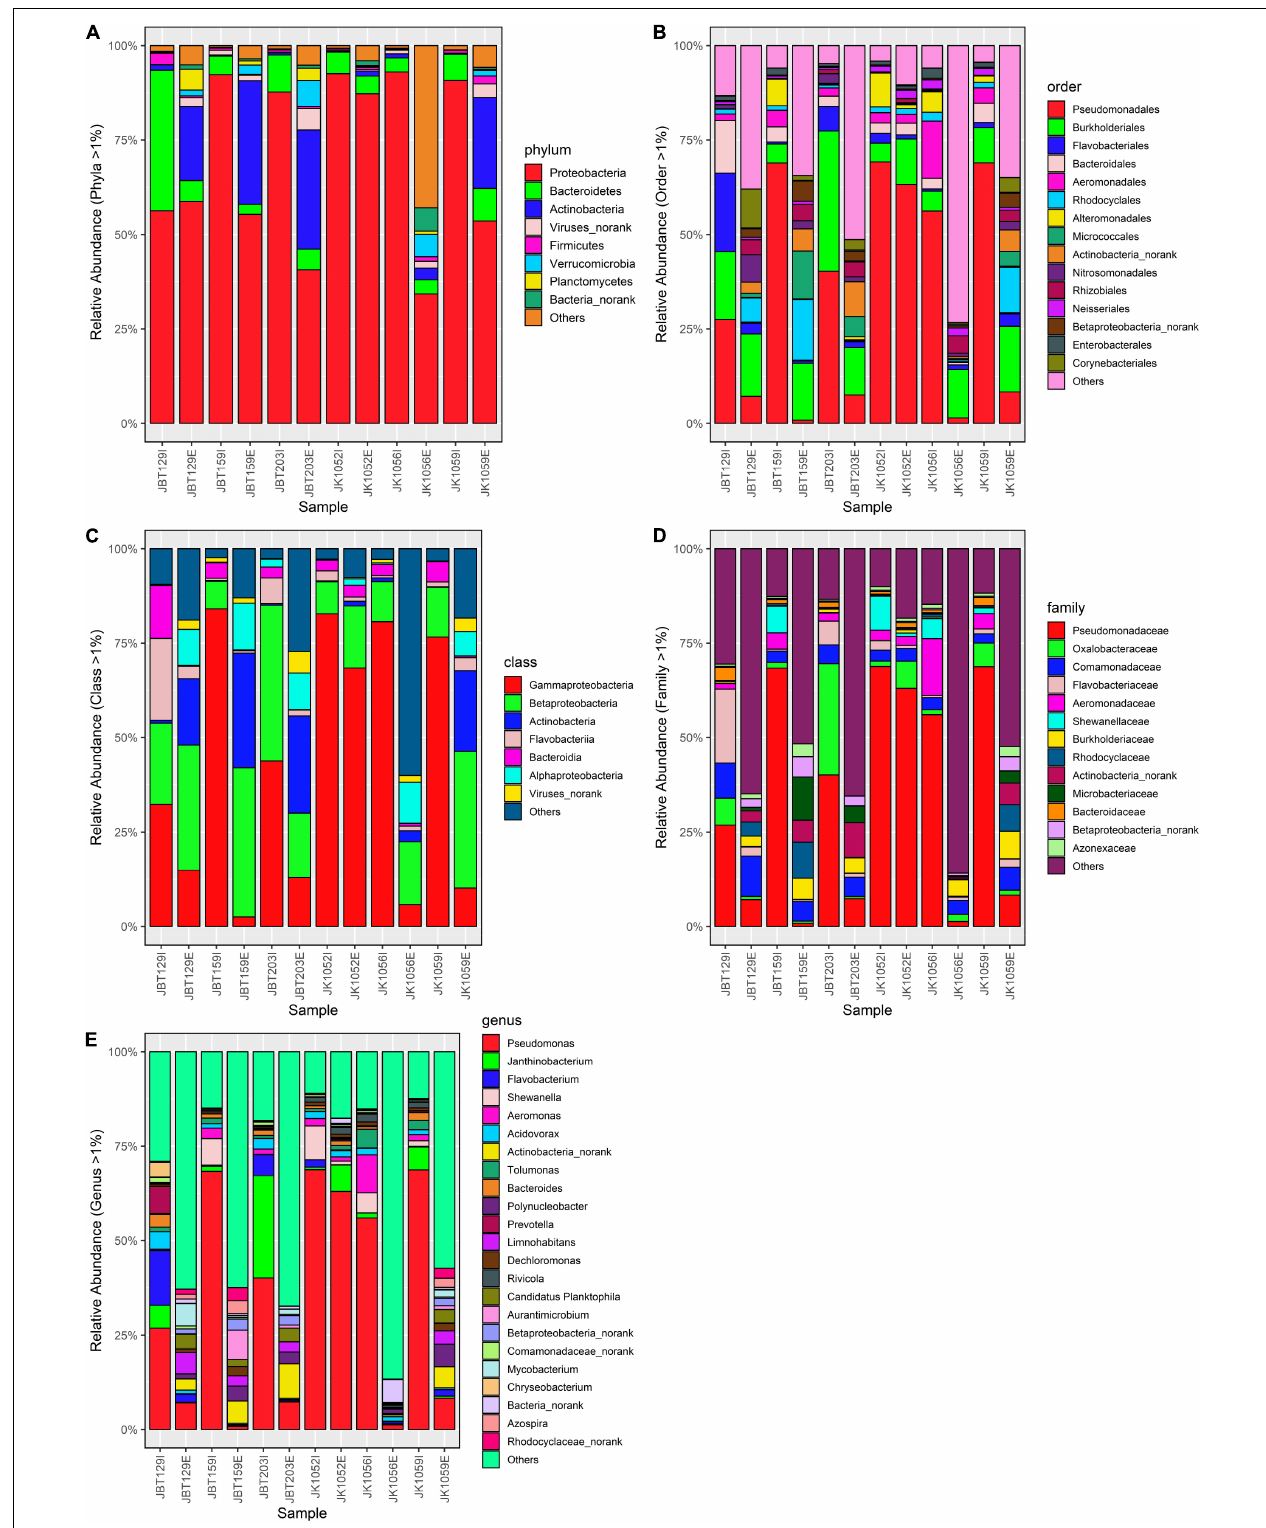
FIGURE 4 | Bar plot of relative (A) phyla-taxa, (B) class-taxa, (C) order-taxa, (D) family-taxa, and (E) genus-taxa abundance in six influent and six effluent WWTP samples. All taxa levels were reported with p -value < 0.05 (Wilcoxon rank-sum statistical test).